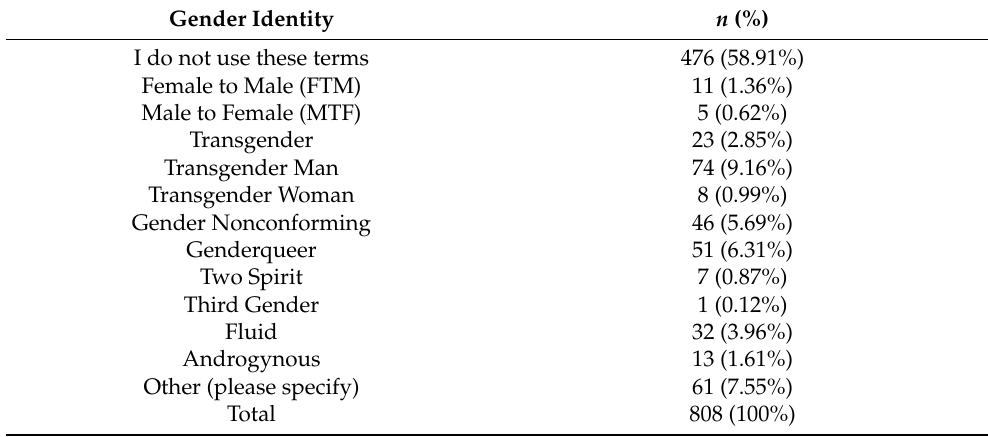
Table 1. Frequency of gender identity.